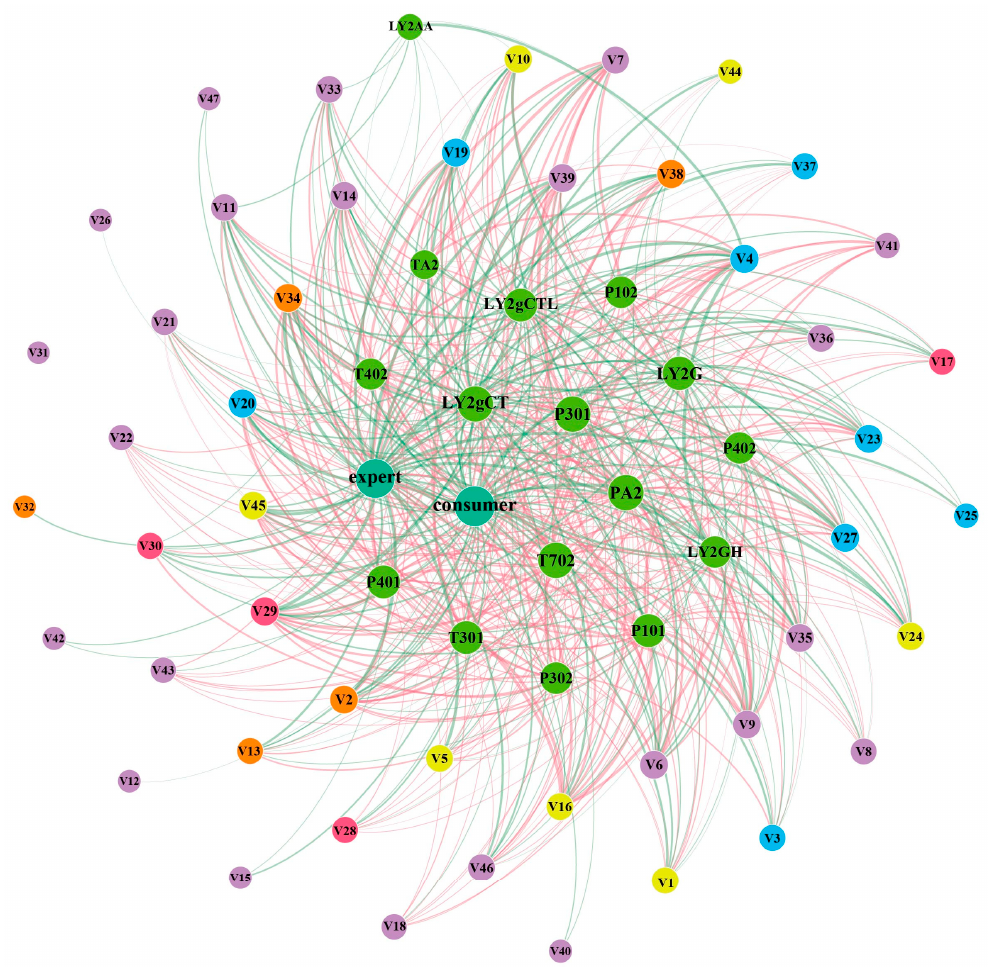
Figure 4. Network diagram of the relationship between electronic nose data, HS-SPME-GC-MS data,